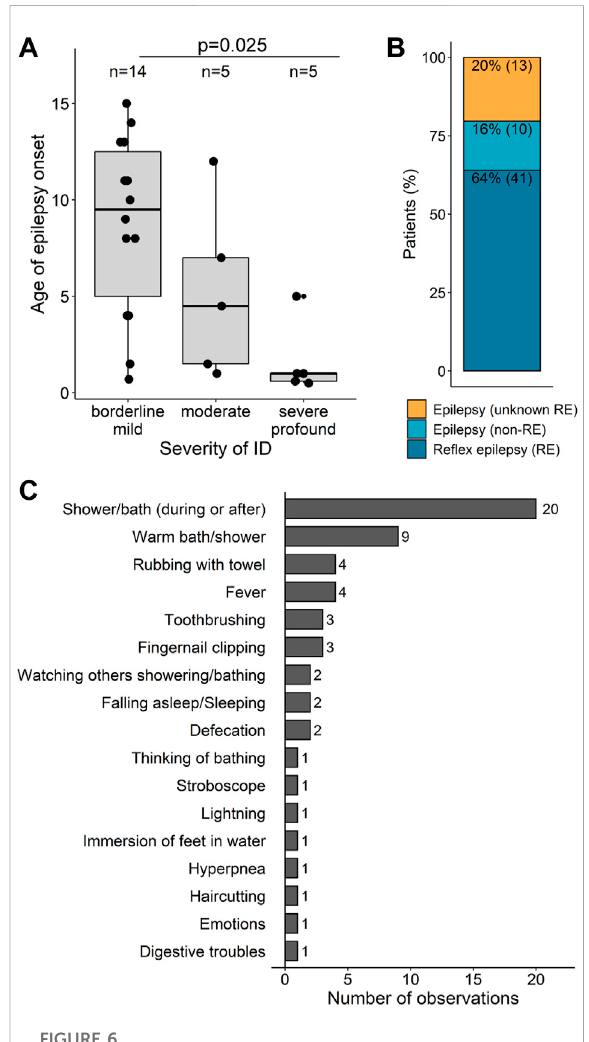
FIGURE 6 Epilepsy types and associations (A) Age of epilepsy onset according to the severity of ID. Patients were grouped into three categoriesofIDseverity:borderline/mild( n =14),moderate( n =5) and severe/profound ( n = 5). Each point represents one patient for which information was obtained. Box plot elements are de fi nedasfollows:centerline:median;boxlimits:upperandlower quartiles; whiskers: 1.5× interquartile range; smaller point outside whiskers: outlier (B) Categorization of epilepsy types. Numbers inside the bars are shown as percentages and ratios for